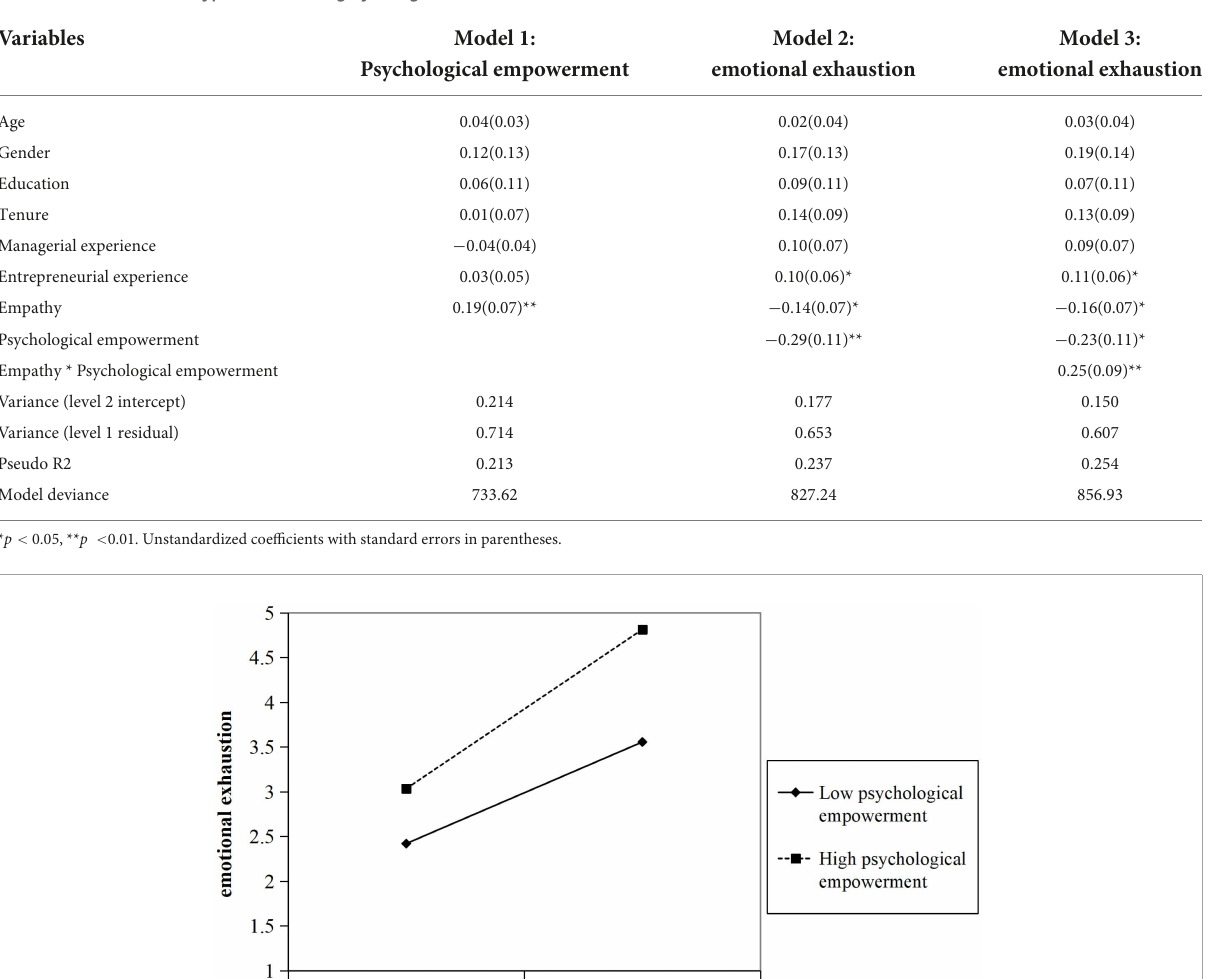
TABLE 3 The results of hypotheses testing by using HLM.